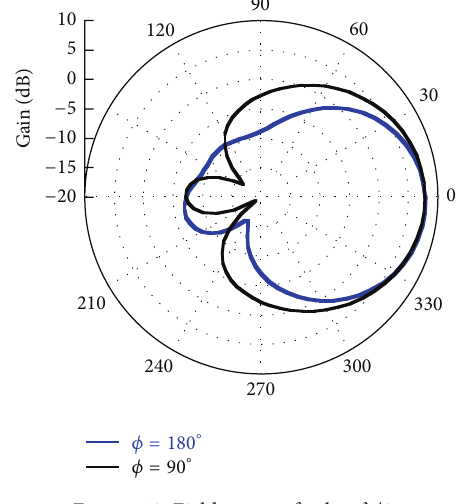
Figure 12: Field pattern for ℎ = 𝜆/8 .